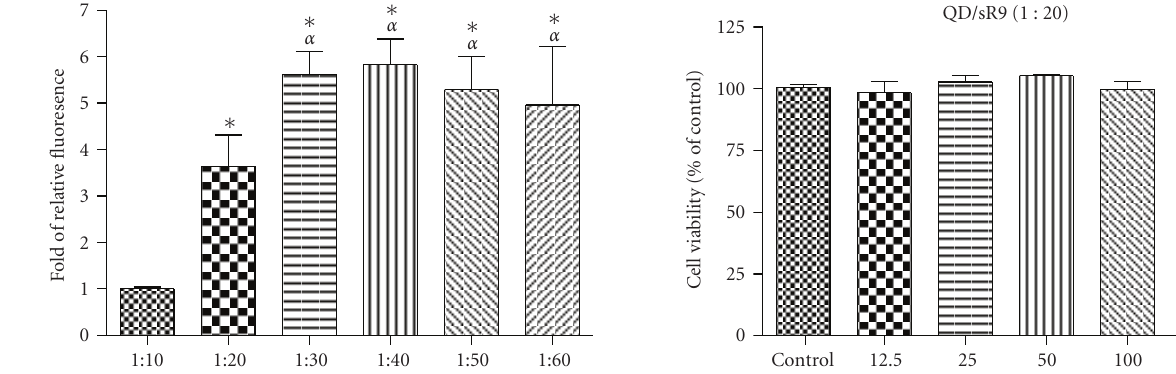
Figure 2: QD uptake with SR9 at di ff erent molecular ratios. QDs were premixed with SR9 at molecular ratios from 1 :10 to 1 :60. A549 cells were treated with QD/SR9. Values are mean ± SD from three independent experiments. Fluorescence intensity is normalized relative to the value at 1 :10. ∗ P < . 01 versus 1 :10; α P < . 01 versus 1 :20.